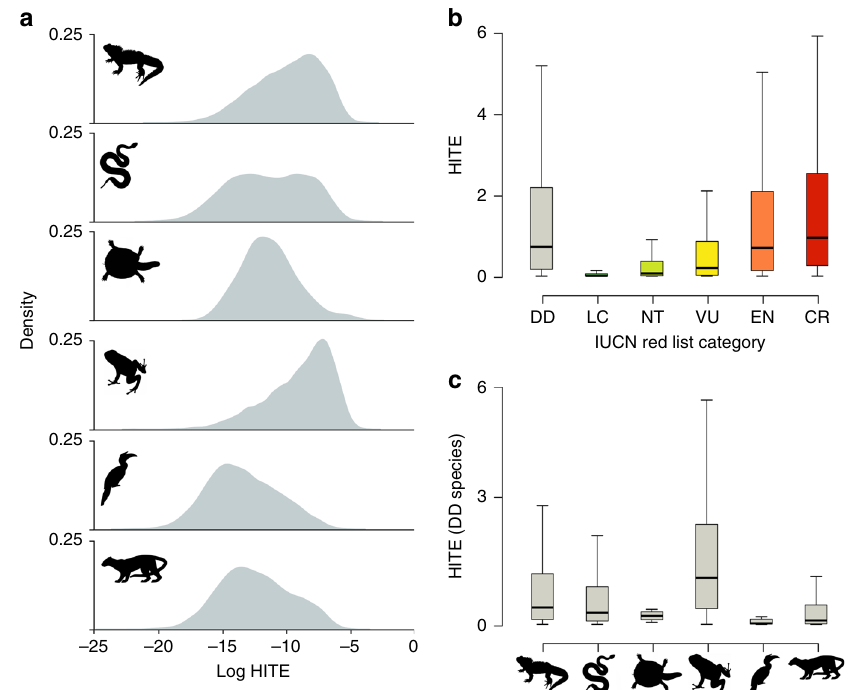
Fig. 5 Distributions of human-impacted terminal endemism (HITE) for tetrapods. a Density distributions of log-transformed HITE scores for tetrapods. Species with long terminal branches occurring in very few grid cells under high human pressure score highly and fall on the right of the x-axis, whereas species with short terminal branches and large ranges encompassing regions of low human pressure fall on the left of the x-axis. Y-axis indicates density of species in each clade with a given HITE value. b Distribution of HITE scores (in 10 − 3 MY − 1 km 2 ) across tetrapods for each IUCN Red List category (excluding Extinct, Extinct in the Wild and unassessed species): Data De fi cient (DD; n = 2604 spp., grey box); Least Concern (LC; n = 15217 spp., dark green box); Near Threatened (NT; n = 1709 spp., light green box); Vulnerable (VU; n = 2007 spp., yellow box); Endangered (EN; n = 1965 spp., orange box); Critically Endangered (CR; n = 1035 spp., red box). c Distribution of HITE scores (in 10 − 3 MY − 1 km 2 ) for Data De fi cient (DD) tetrapod species for key tetrapod groups, from left to right on x -axis: lizards ( n = 478 DD spp.), snakes ( n = 404), turtles ( n = 8), amphibians ( n = 1222), birds ( n = 35) and mammals ( n = 457). For boxplots, centre line = median; box limits = upper and lower quartiles; whiskers = 1.5x interquartile range. Source data are provided as a Source Data fi